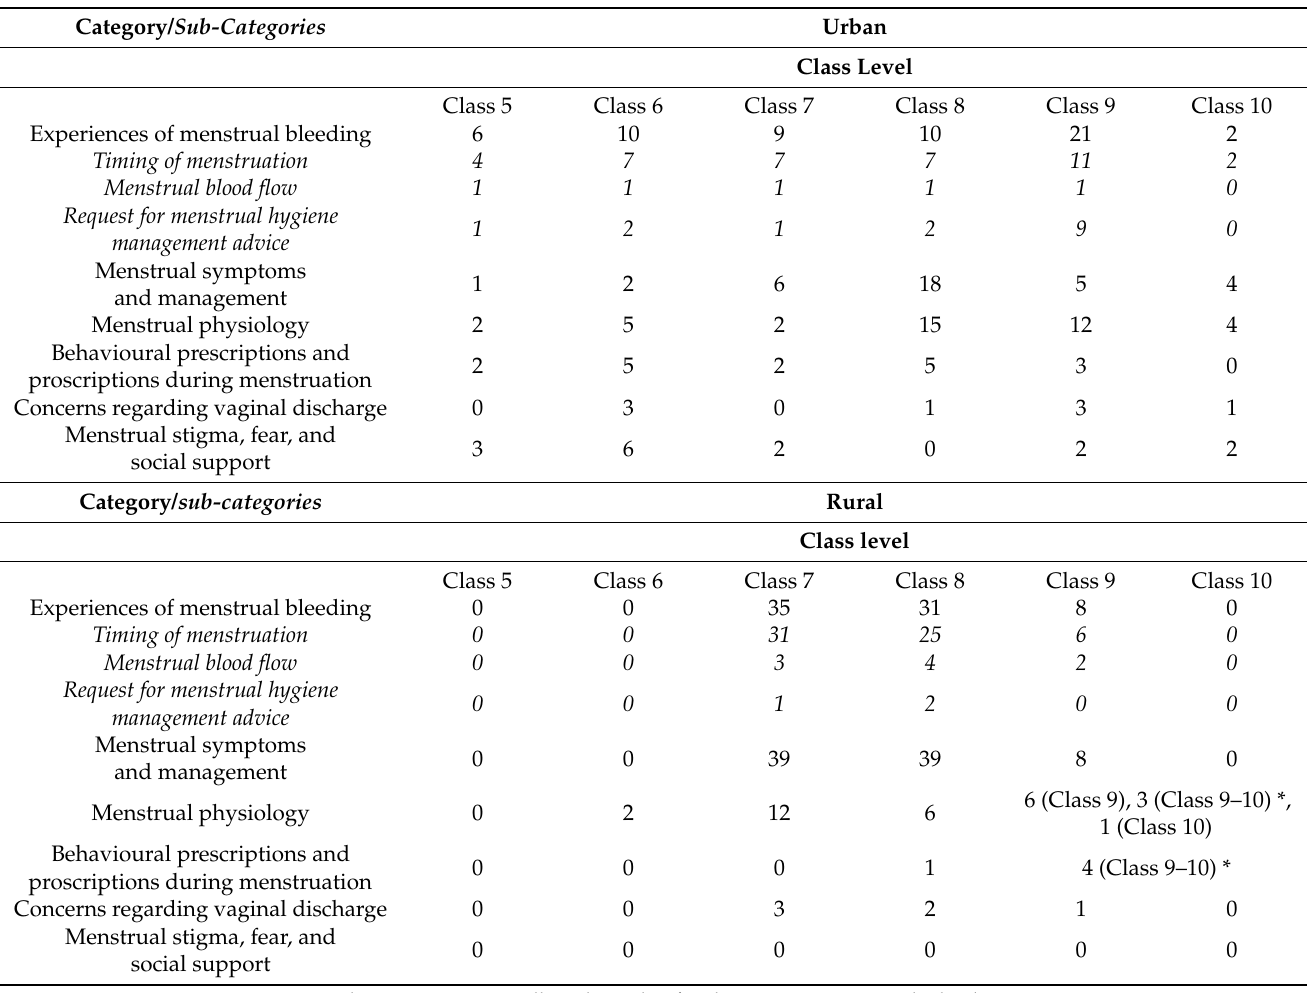
Table 2. Number of menstruation-related questions submitted by students in the urban and rural schools in Bangladesh 2017–2018, reported by category/sub-category and class